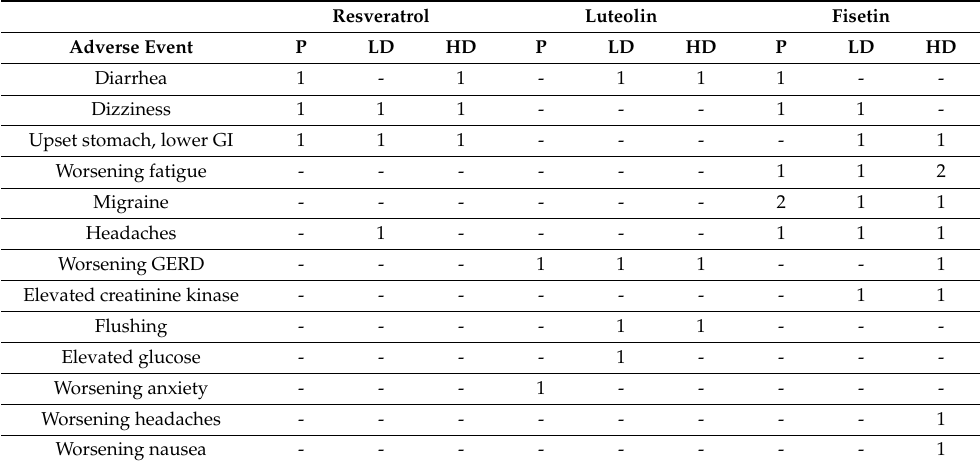
Table 2. Incidence of self-reported adverse